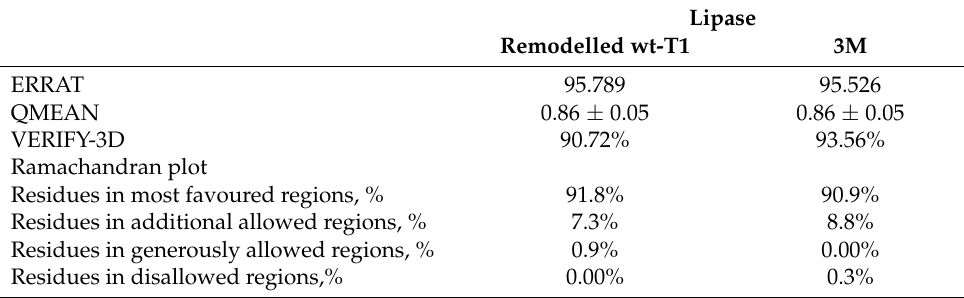
Table 2. Summary of validation data of